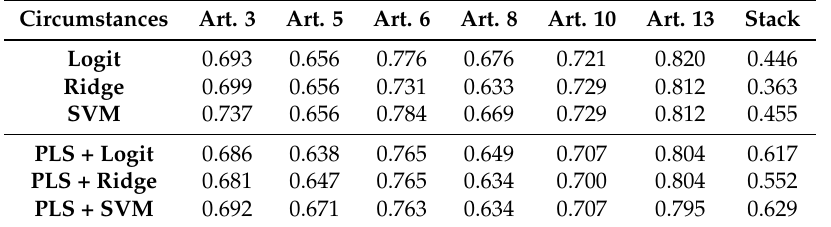
Table 3. Accuracy with binary input on circumstances.